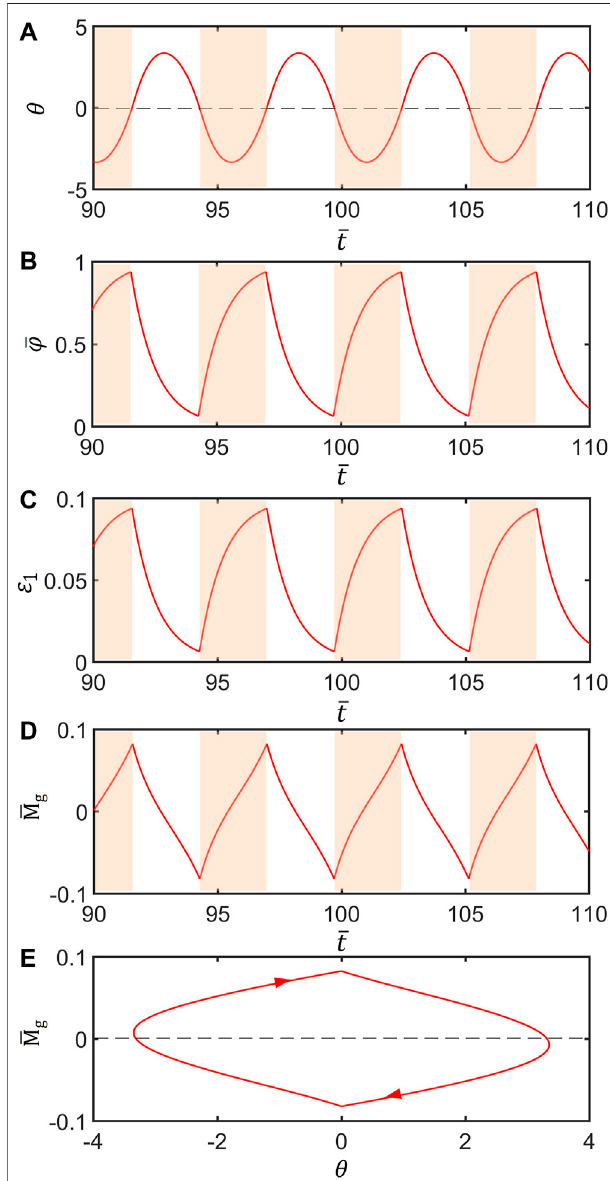
b (cid:2) 0 . 5mm, h (cid:2) 0 . 5mm, ρ (cid:2) 10 3 Kg/m 3 , E (cid:2) 1MPa, C 0 (cid:2) 0 . 5, (cid:2) 10 5 W · m − 2 , T (cid:2) 10 − 1 s, η (cid:2) 10 − 4 . Then, the corresponding I 0 0 0 (cid:2) dimensionless parameters are estimated as I (cid:2) 0 ∼ 1, FIGURE 3 | Mechanism of the self-stabilized oscillation of the LCE (cid:2) g (cid:2) 1 ∼ 10 2 , (cid:2) ζ (cid:2) 0 ∼ 10 2 . The numerical calculations show that inverted pendulum. Parameters are set: (cid:2) I (cid:2) 0 . 25, C 0 (cid:2) 0 . 4, (cid:2) g (cid:2) 9 . 8, (cid:2) ζ (cid:2) 14 . 7, (cid:2) 0 ° , θ (cid:2) 70 ° , and _ θ (cid:2) 0. (A) The rotation angle as a function of time. (B) θ 0 1 0 The variation of the number fraction of cis -isomers in the OA bar with time. (C) The contraction strain as a function of time. (D) Dependence of the gravity moment on time. (E) Thevariationofthe gravity moment with theangle of